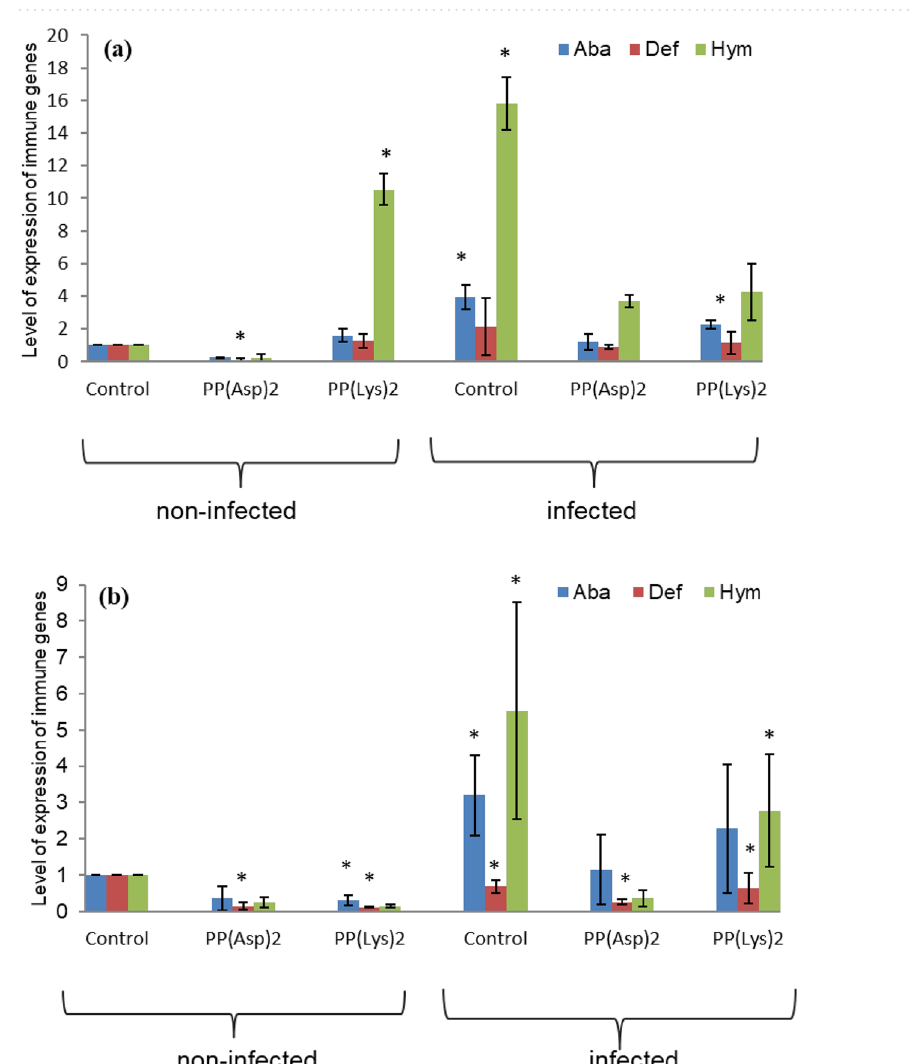
Figure 7. Effect of porphyrins PP(Asp) 2 and PP(Lys) 2 on immune-related AMP gene expression in honeybees ( a ) on day 3 post N. ceranae -infection; ( b ) on day 4 post N. ceranae -infection. Aba—abaecin, Def—defensin, Hym—hymenoptaecin. Non-infected control and infected control bees fed with sucrose syrup only. Bars marked with asterisks are statistically significantly different from the non-infected control; error bars represent standard errors of